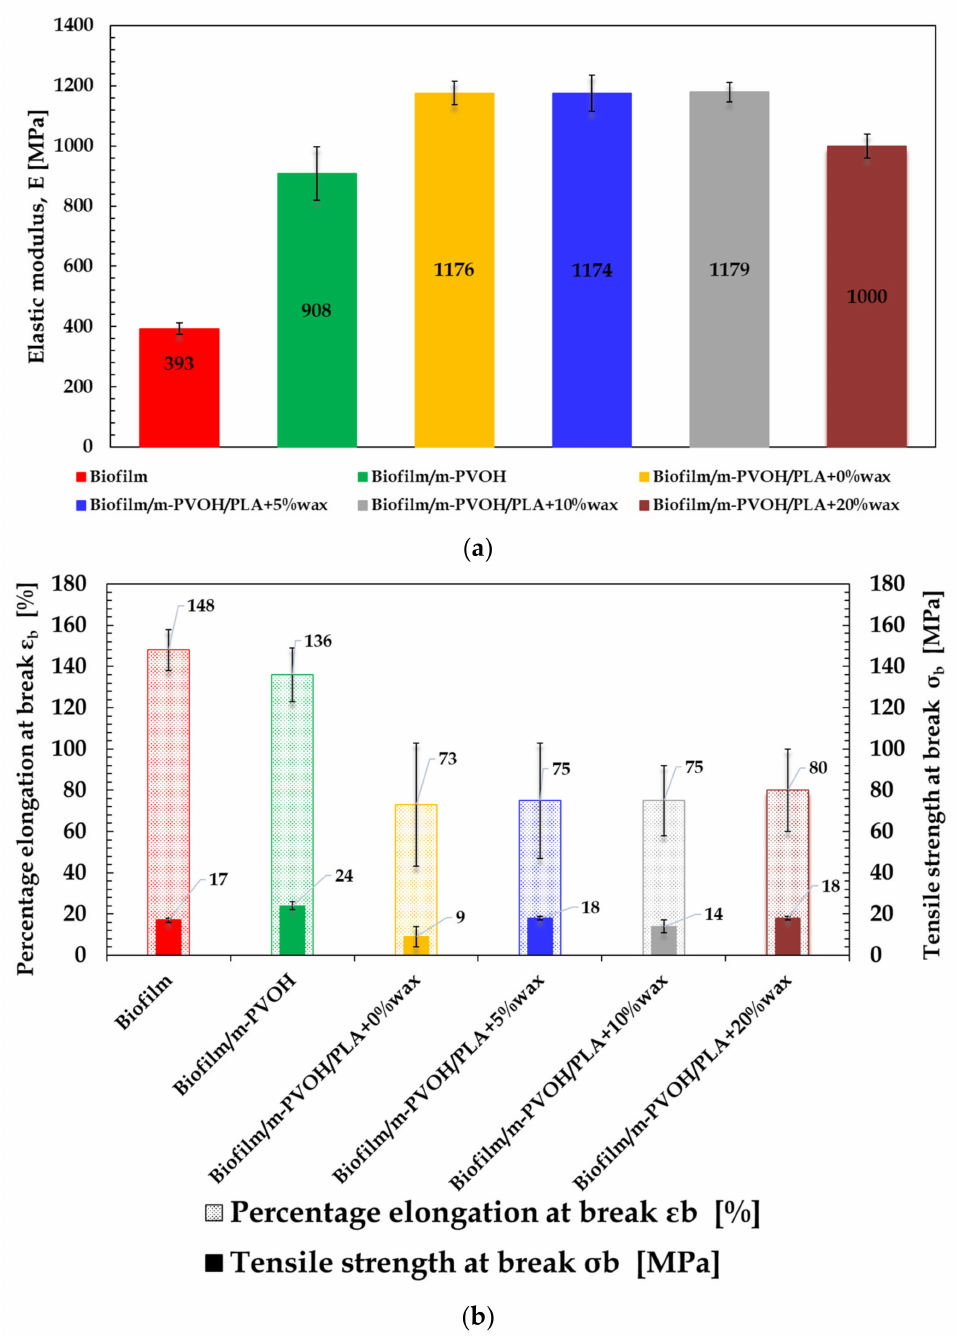
Figure 8. Elastic modulus (E) ( a ) and elongation at break ( ε b ) and tensile strength at break ( σ b ) ( b ) for pure Biofilm substrate and multilayer